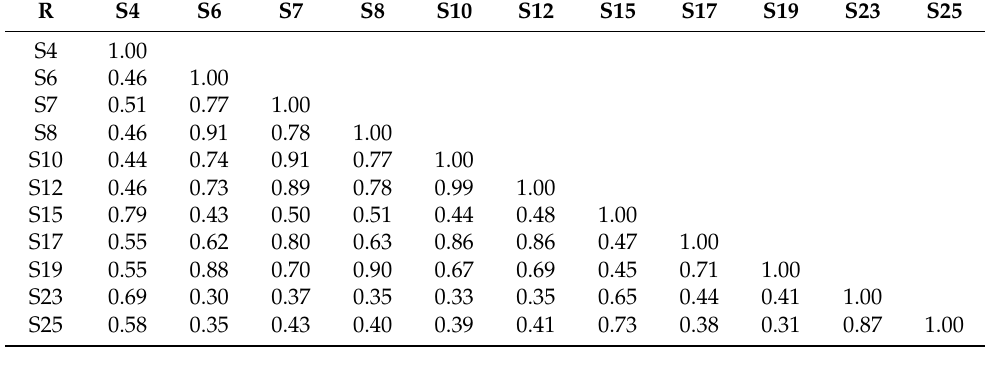
Table 9. Correlation matrix of sensor-measured NO 2 concentrations.